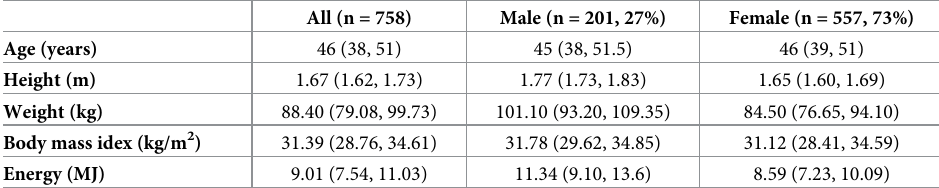
Table 2. Participant characteristics of the pooled data set � .